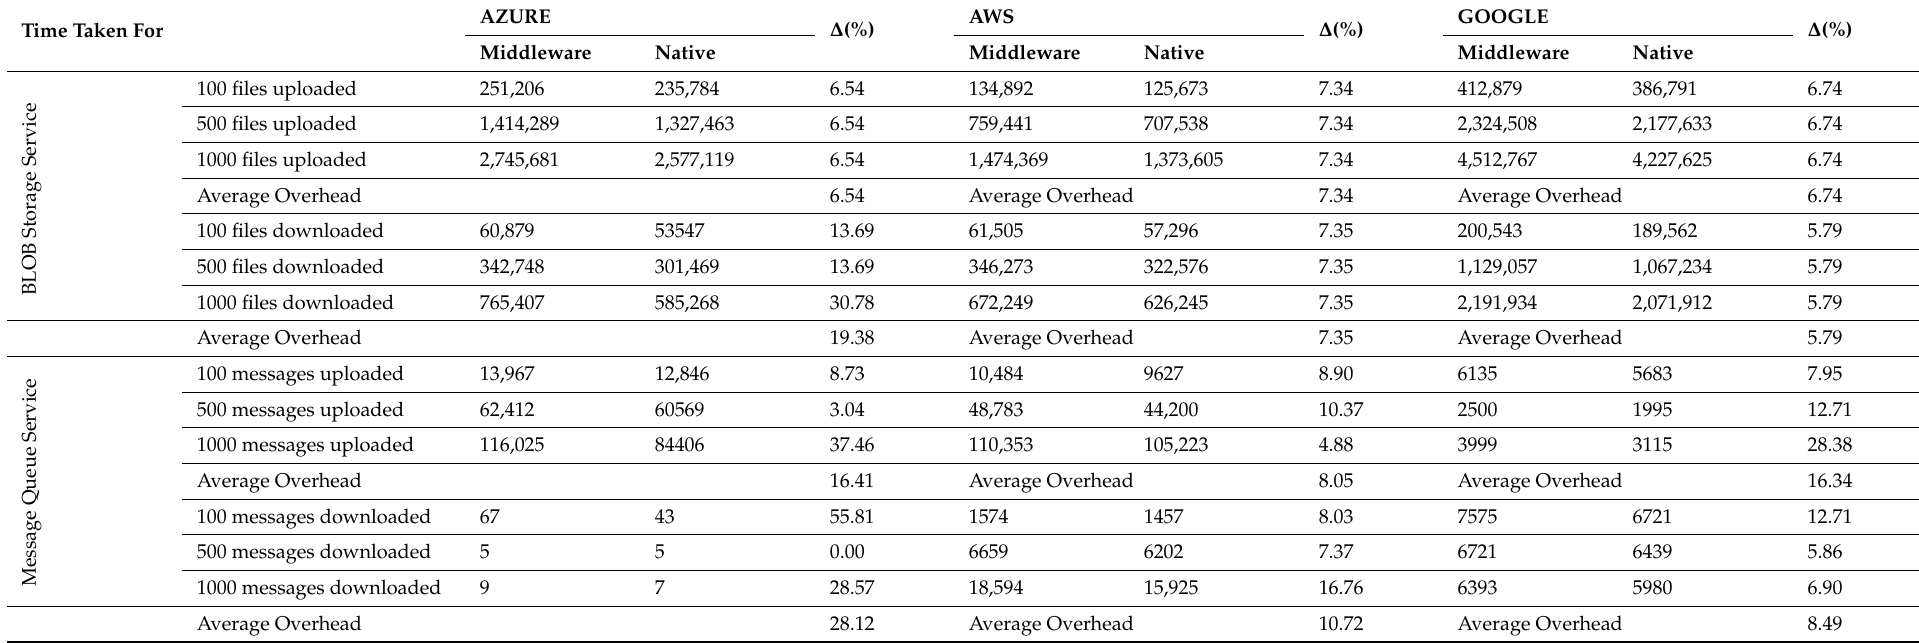
Table 2. Values of latency times. Values of latency times for BLOB storage and message queue